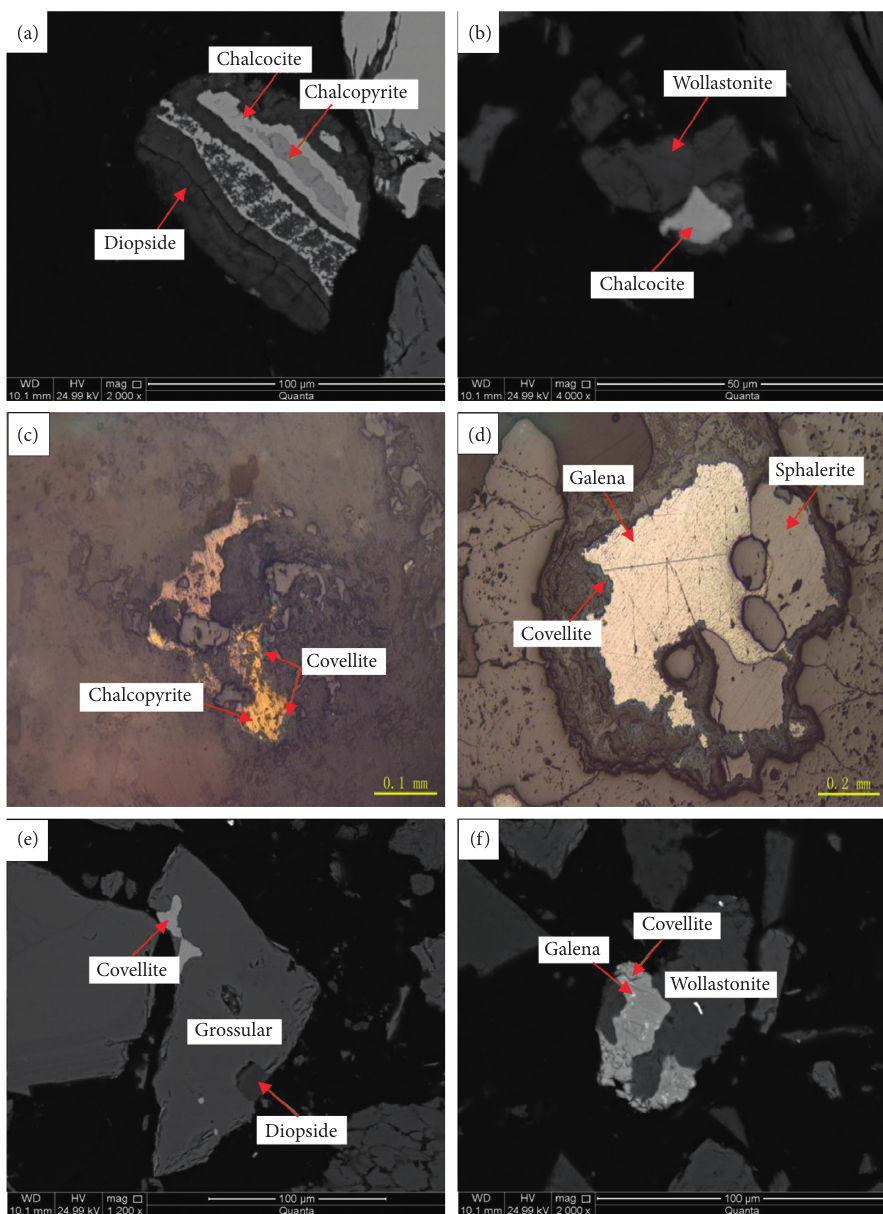
Figure 3: Embedded characteristics of chalcocite and